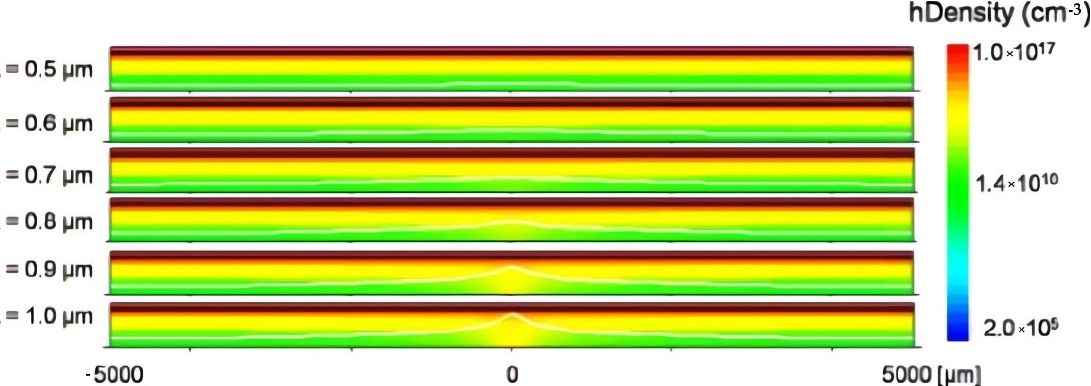
Figure 4. Distribution of minority carriers near the space charge region. The white lines show the border of the space charge region [6].